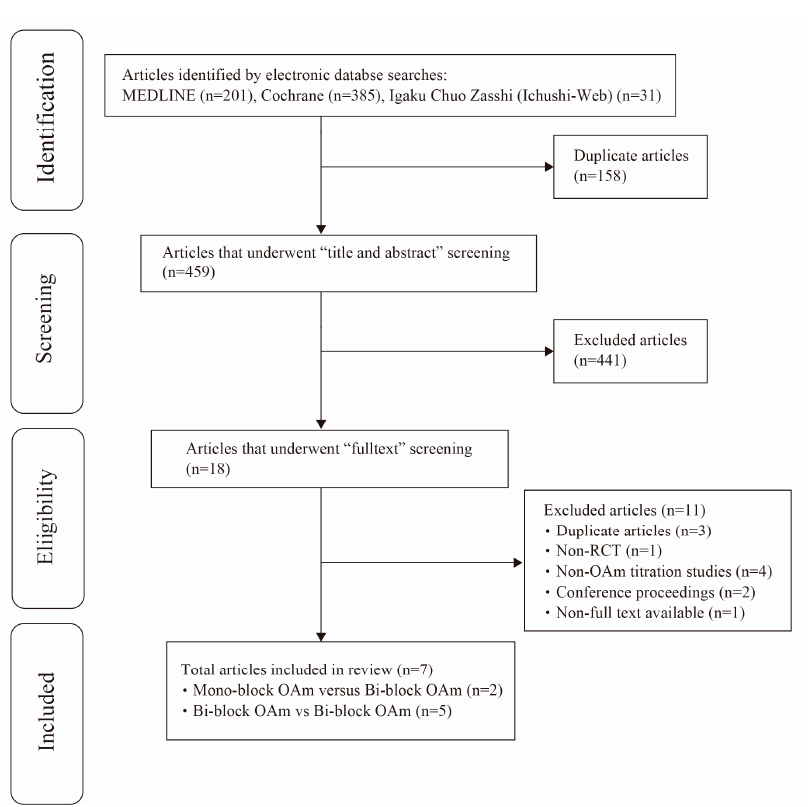
Figure 2. PRISMA flow diagram of selection process.